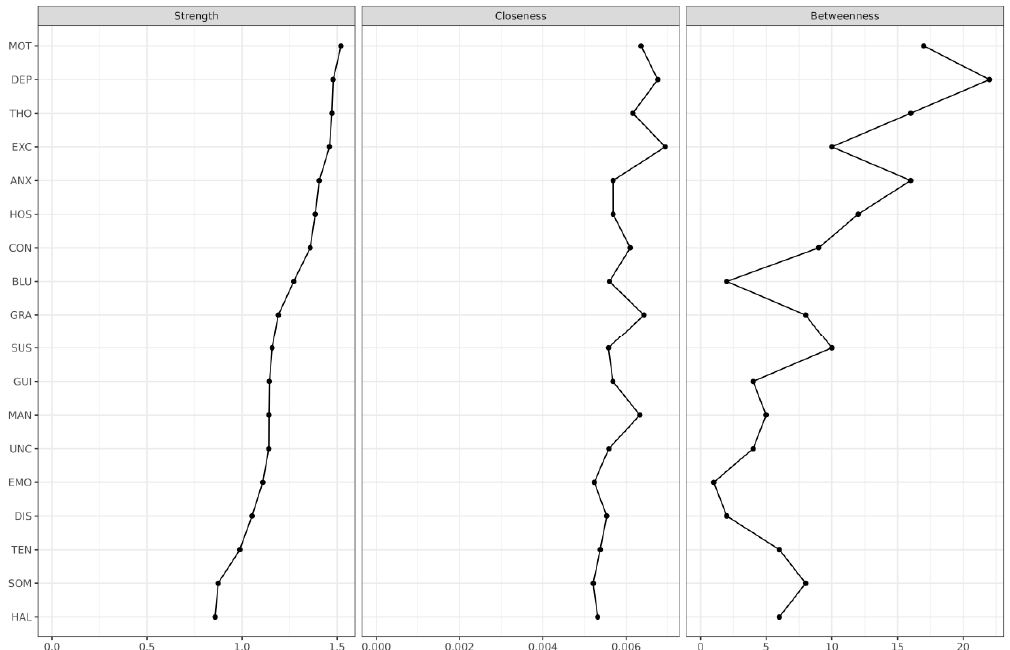
Figure 2. Node statistics including node strength centrality, closeness centrality, and betweenness centrality ( n = 1438). Abbreviations: ANX, anxiety; BLU, blunted affect; CON, conceptual disorganization; DEP, depressive mood; DIS, disorientation; EMO, emotional withdrawal; EXC, excitement; GRA, grandiosity; GUI, guilt feelings; HAL, hallucinatory behavior; HOS, hostility; MAN, mannerism and posturing; MOT, motor retardation; SOM, somatic concern; SUS, suspiciousness; THO, unusual thought content; UNC, uncooperativeness.